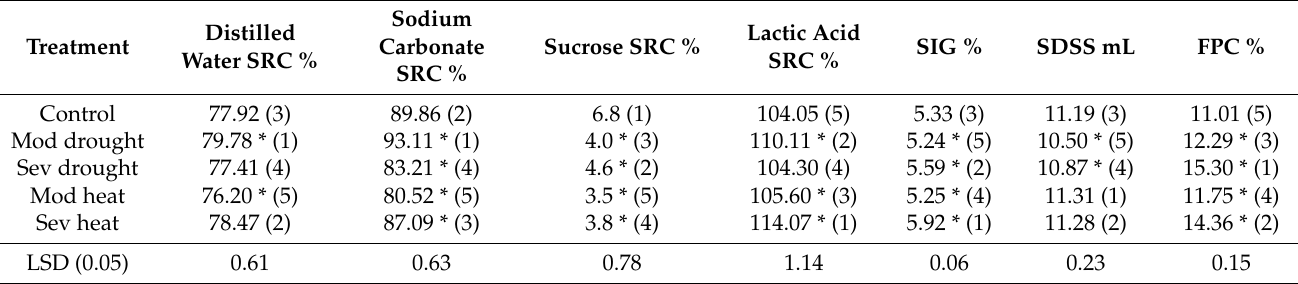
Table 3. Solvent retention capacity, swelling index of glutenin, SDS sedimentation and flour protein content averaged for six cultivars and two seasons.